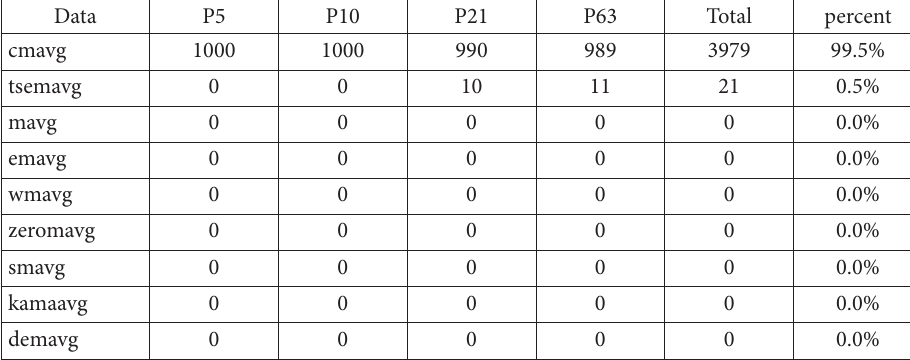
Table 3. Summary of experiments with random data